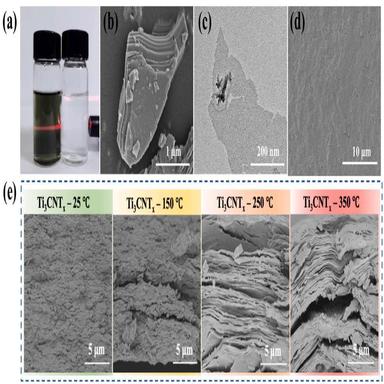
(a) The optical photo of MXene suspension. (b) SEM image of Ti3AlC2. (c) TEM image of single-layer or few-layer MXene nanosheets. (d) SEM image of the surface of MXene coating. (e) Cross-sectional SEM images of MXene coatings treated at 25, 150, 250 and 350 ◦C for 6 h.